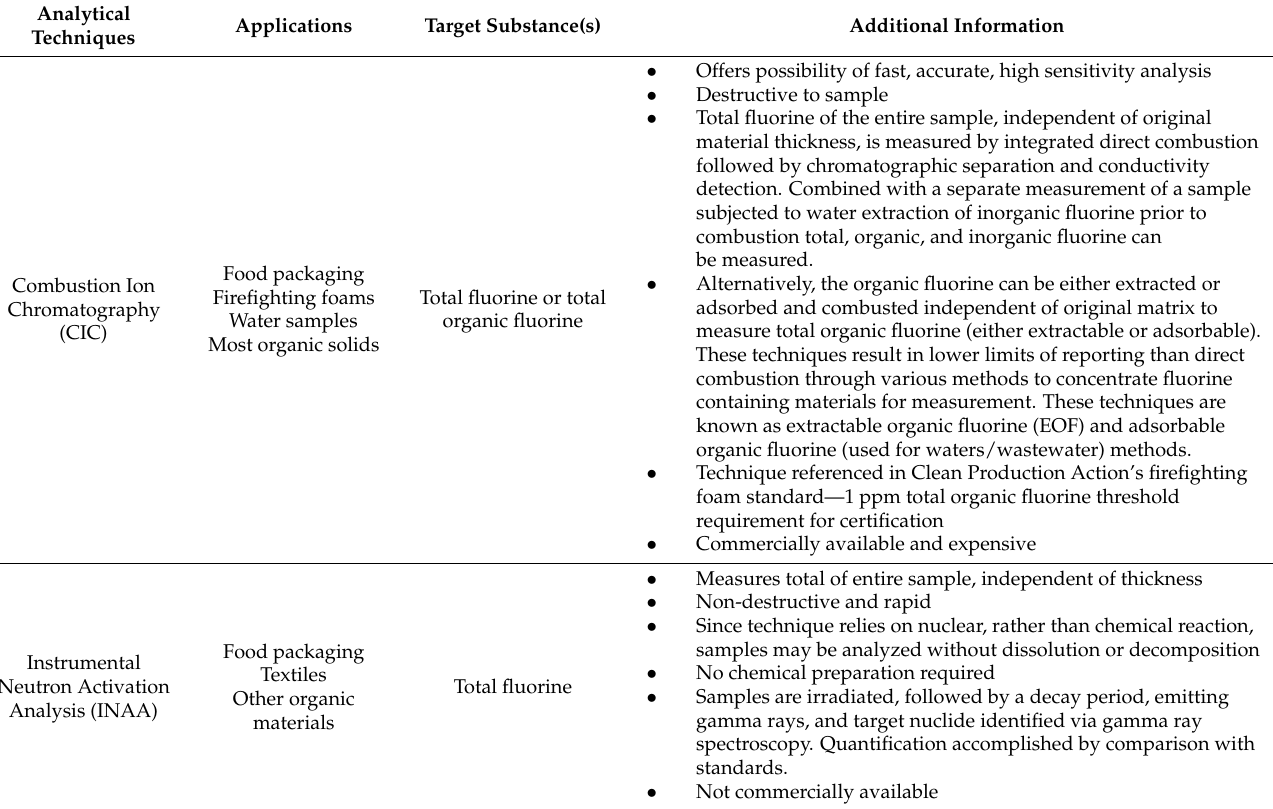
Table 1. Guide to common testing methods for total fluorine and total organic